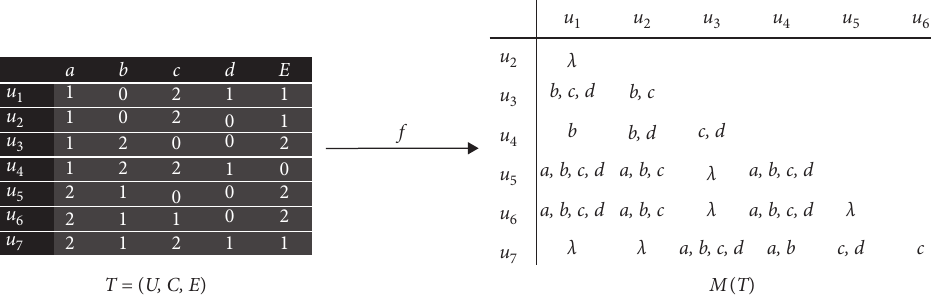
Figure 2: Discernibility function of information